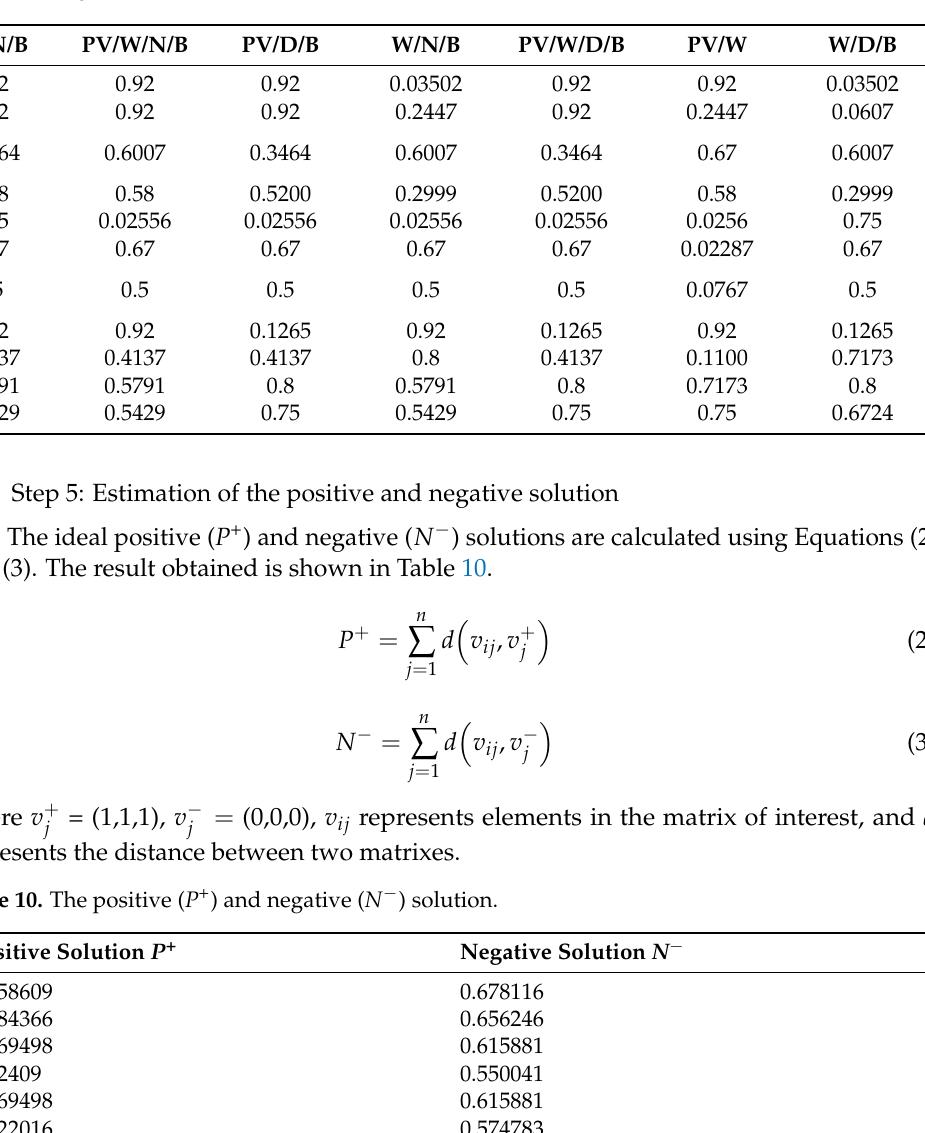
Table 9. Weighted decision matrix.